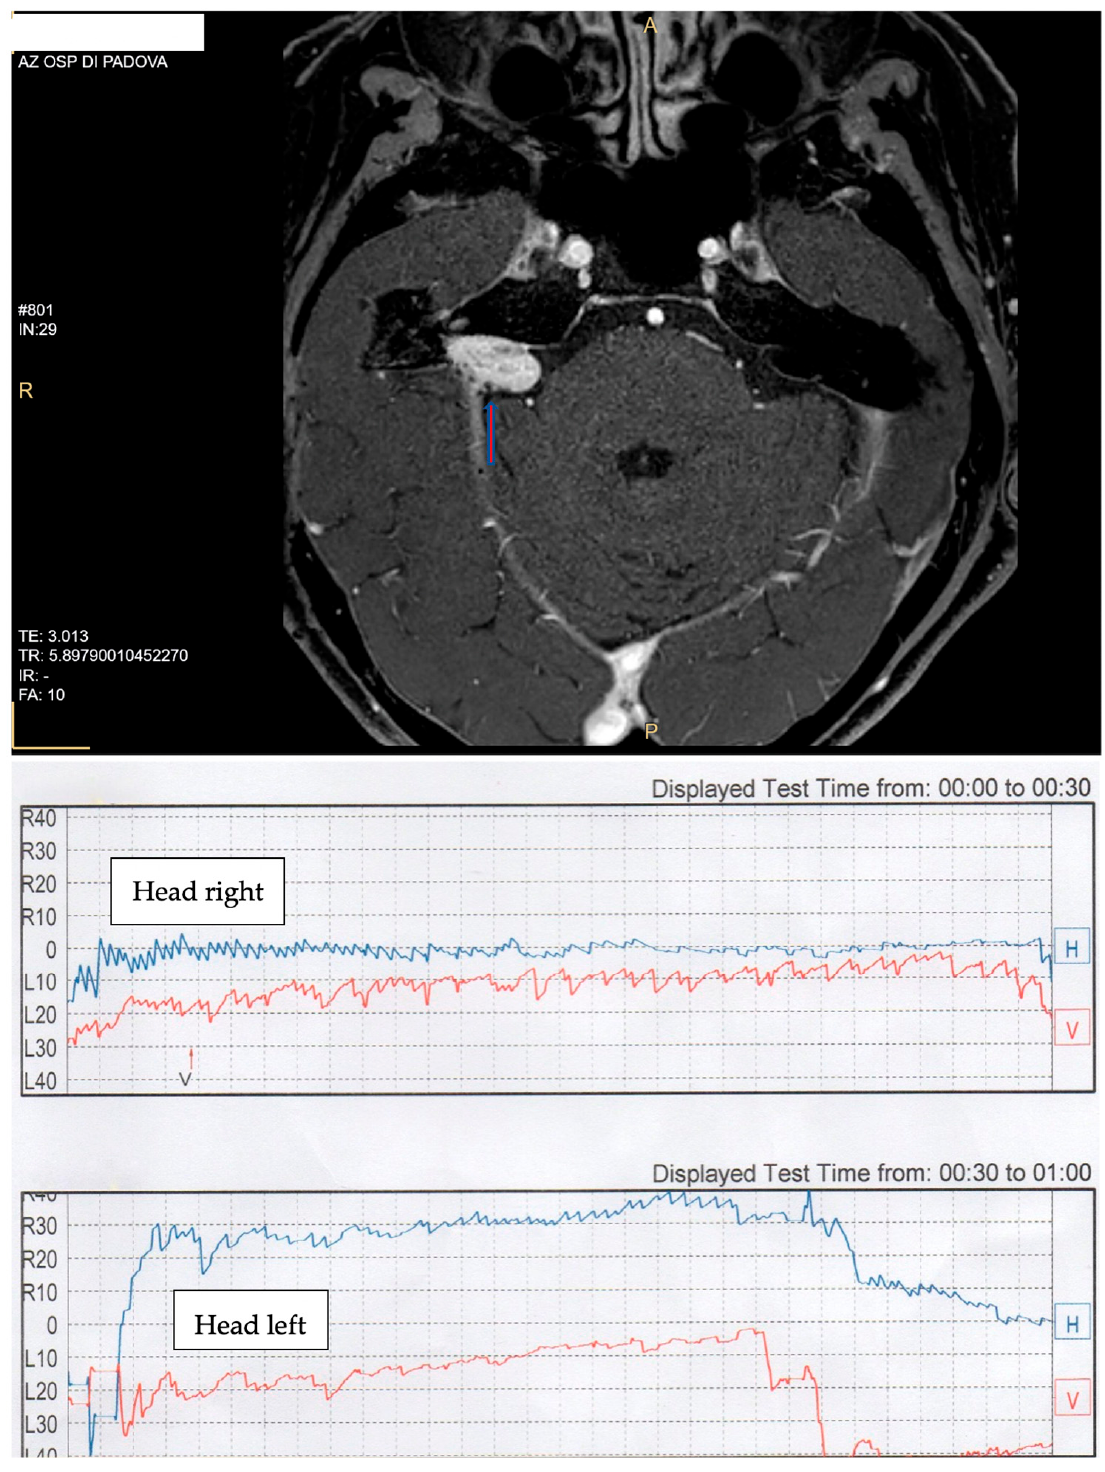
Figure 2. Case CC. ( Top ): AN in the right CPA (arrow). ( Bottom ): videonistagmographic recording of Pagnini–McClure positional test. A geotropic direction-changing horizontal nystagmus was present, with a crescendo–decrescendo pattern, short latency, and a vertical downbeat component in the right side (video).